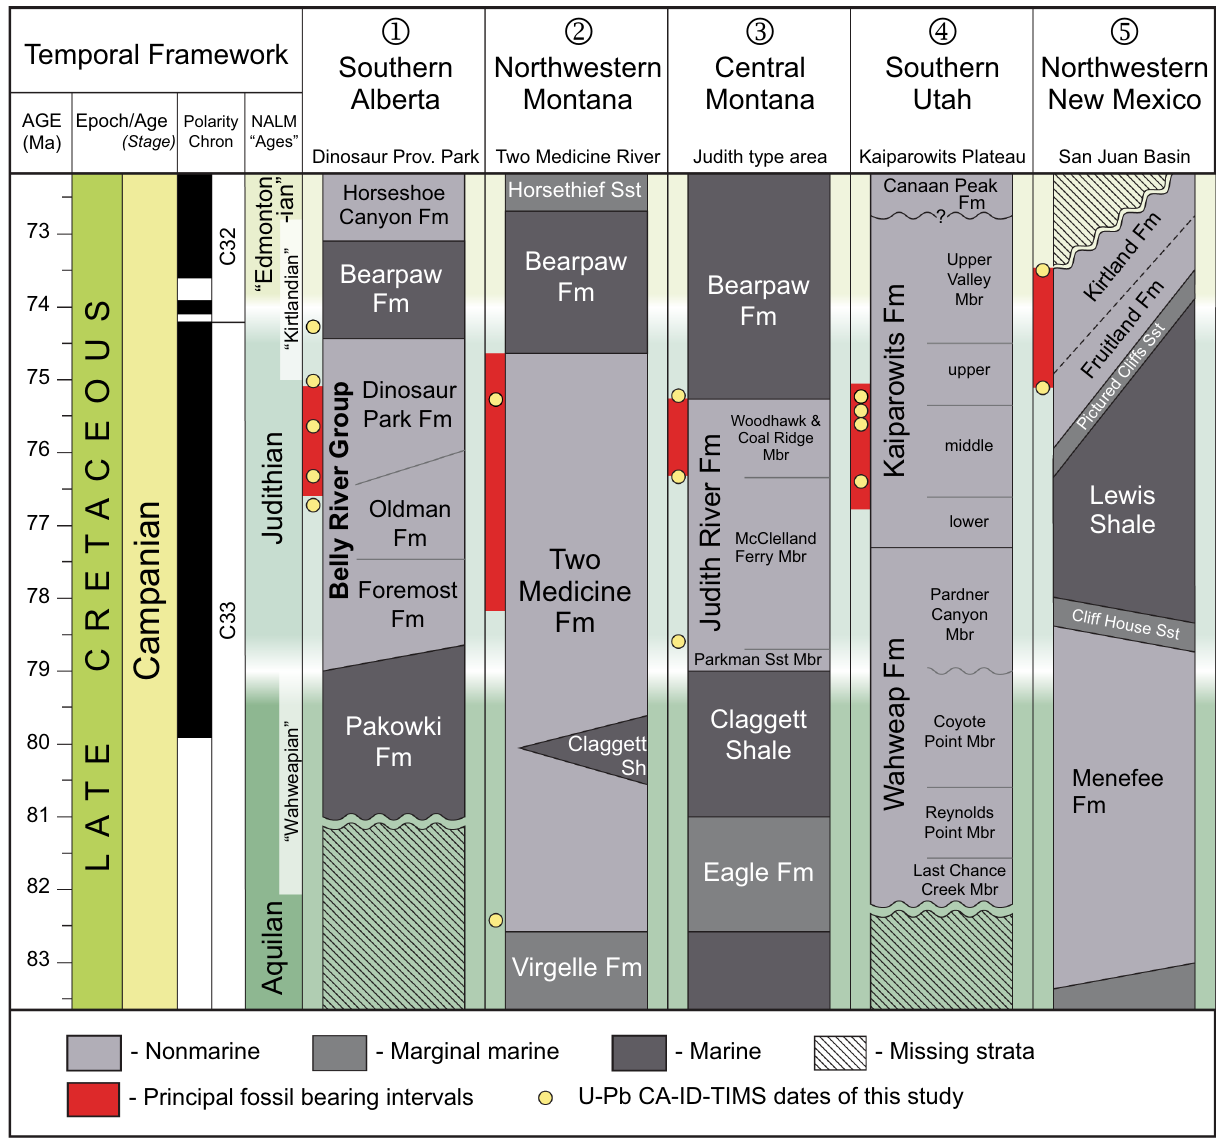
Figure 2. Correlation chart of rock formations and principal vertebrate-bearing continental deposits of Campanian age in the Western Interior Basin, modified from Roberts et al. 105 with new data 86,114,126 and the results of this study. Shown in red are the calibrated temporal ranges of principal fossil-bearing intervals (excluding uncertainties). Fm, Formation; Mbr, Member; NALM, North American Land Mammal; Sh, shale; Sst,